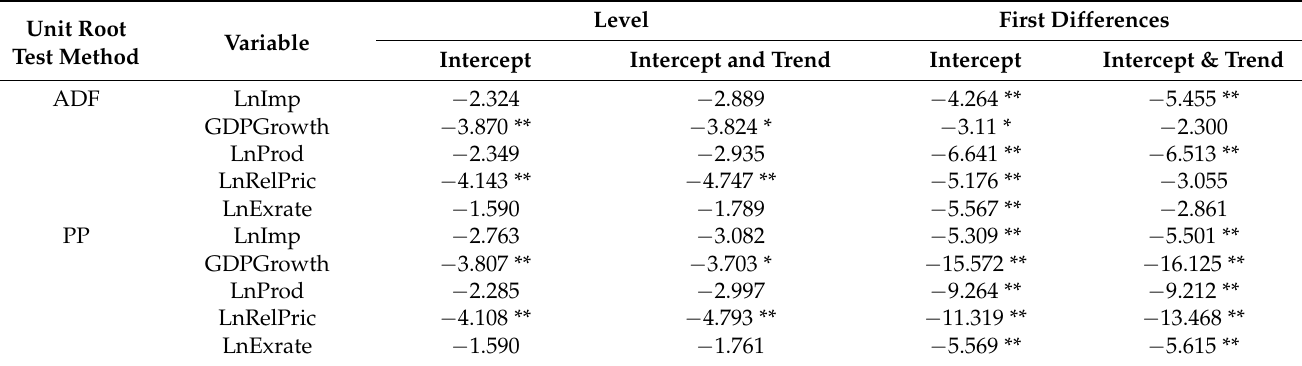
Table 4. Unit root test